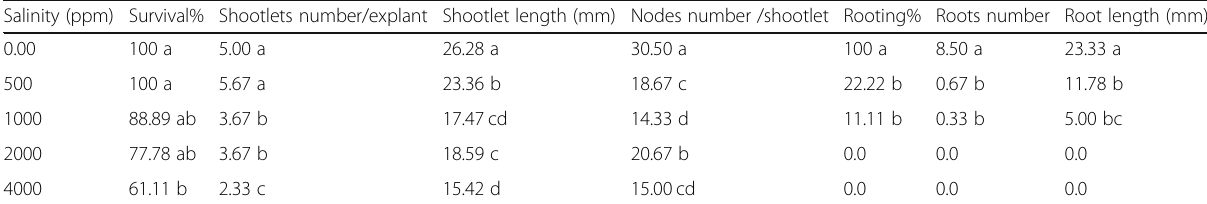
Table 2 In vitro shooting and rooting behaviors of Paulownia under the effect of salinity stress